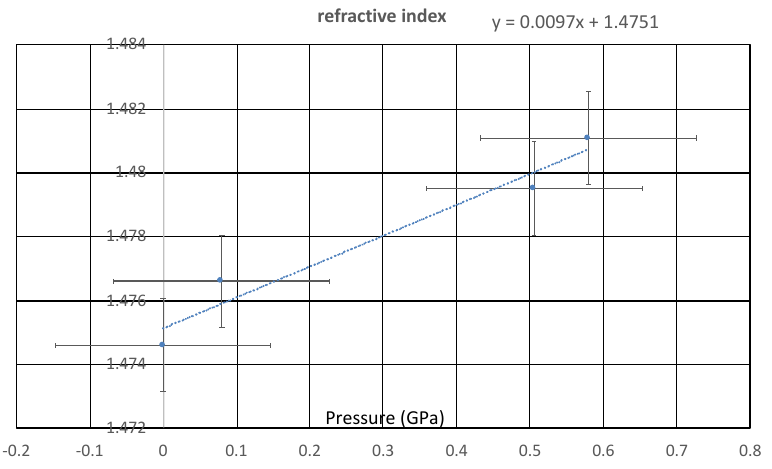
y = 0.0097x + 1.4751